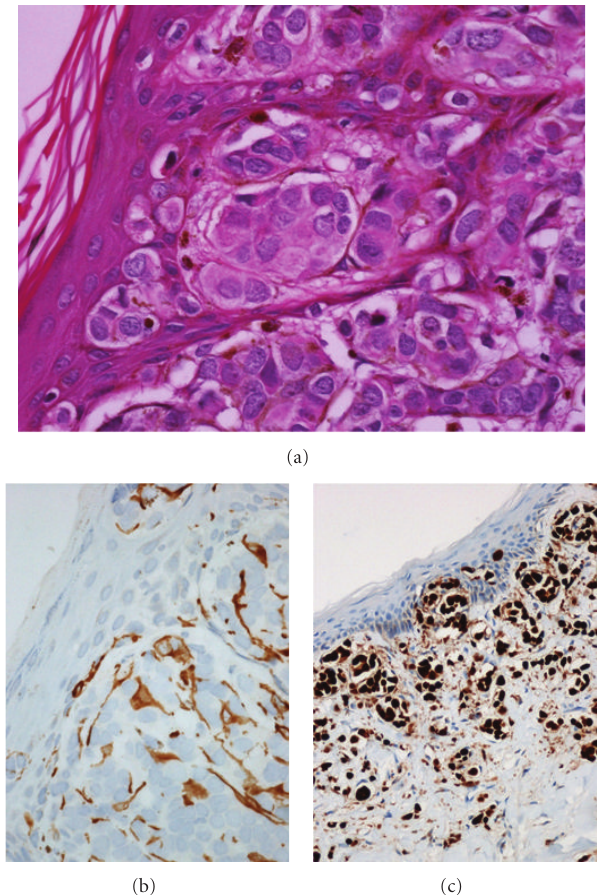
Figure 2: (a) Melanocytes colonizing the underlying carcinoma cells. (HE × 40). (b) Carcinoma cells surrounded by melan-A- positive melanocytes ( × 40). (c) Estrogen receptor positive carci- noma cells ( ×